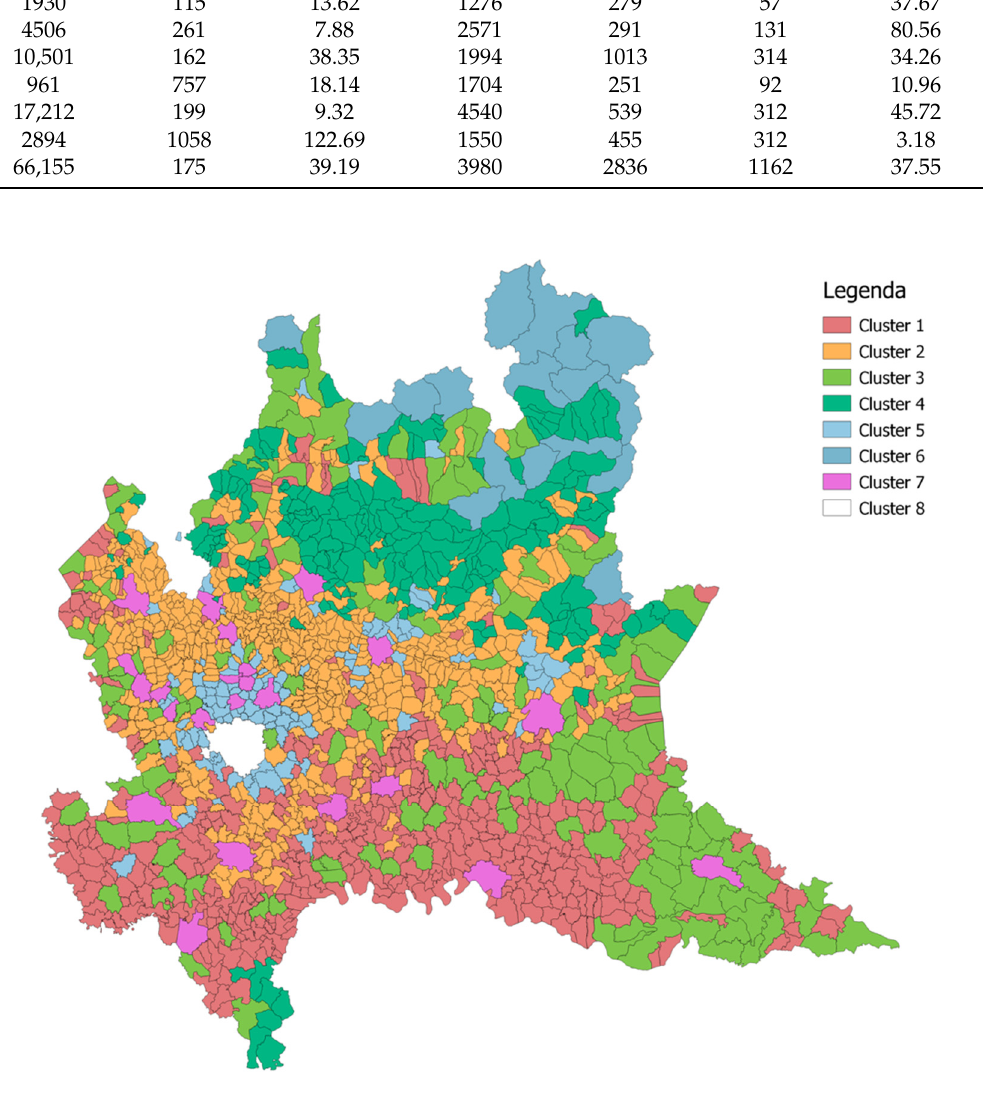
Figure 5. Geographical output of the cluster analysis with 7 clusters and the regional capital of Milan (cluster 8).